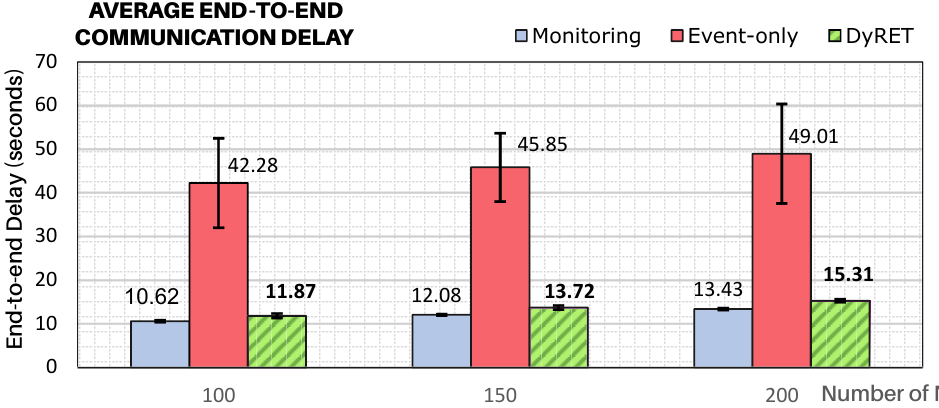
Figure 11. Average end-to-end communication delay for all sensor